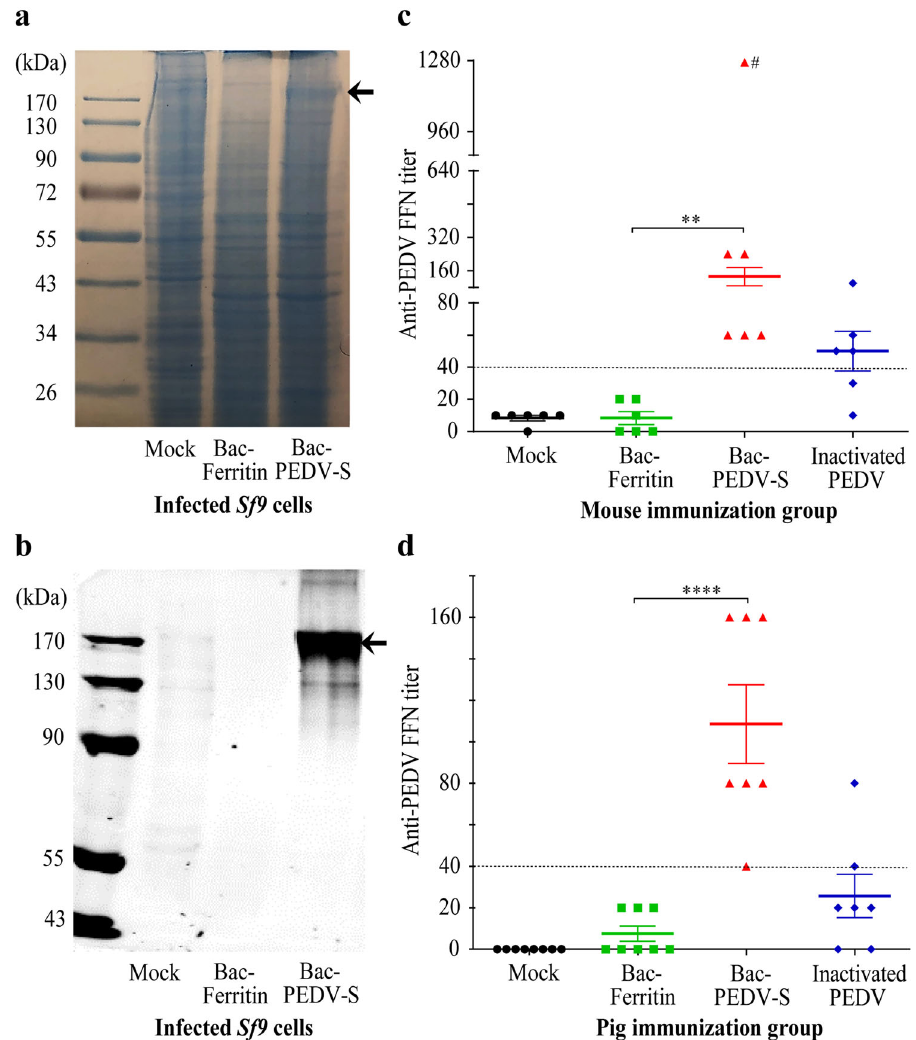
antibody. Neutralizing antibodies in mice ( c ) and piglets ( d ) of different treatment groups were evaluated by FFN assay 4 . The meaning of error bars and marked signs were described in the “ Methods ”